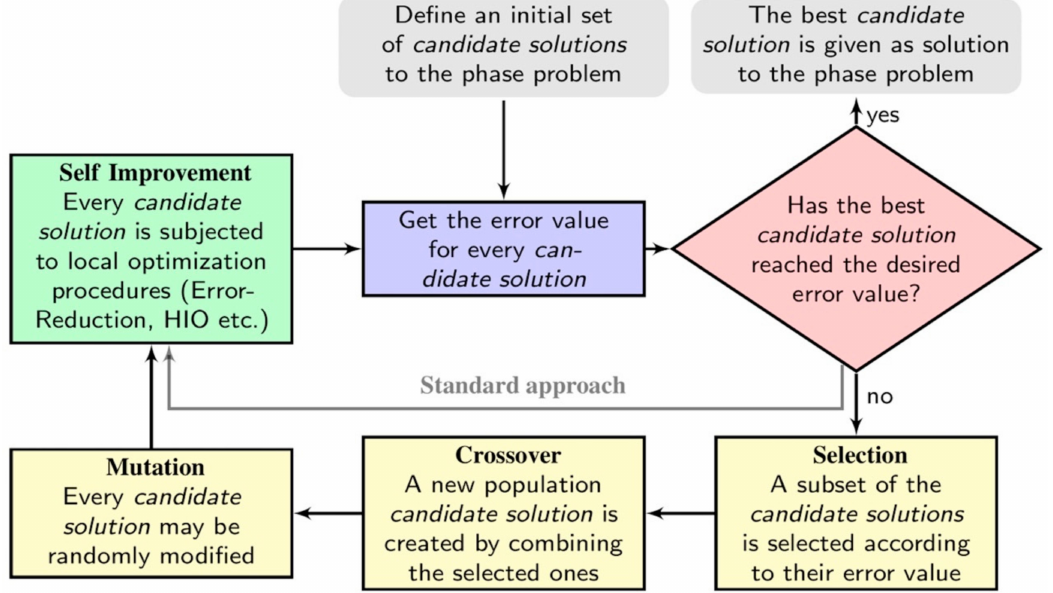
Figure 5. Description of the Memetic Phase Retrieval (MPR) approach. The standard approach can be interpreted as MPR deprived of genetic operations of Selection, Crossover and